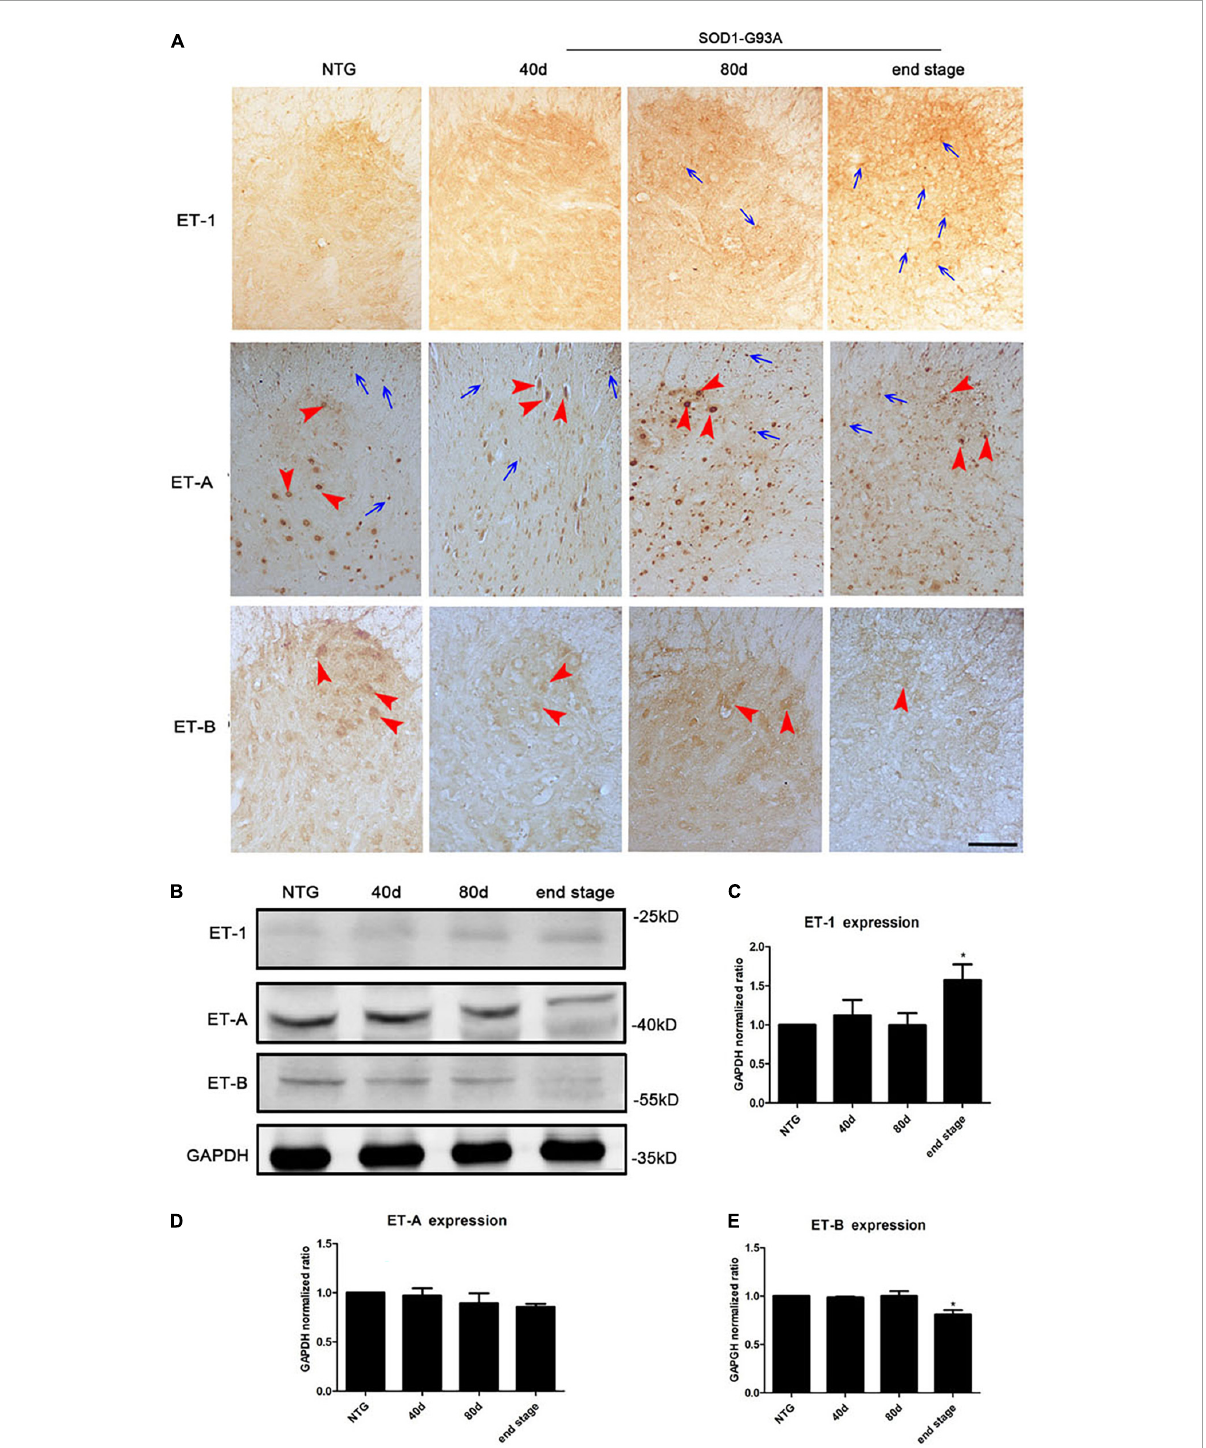
FIGURE1 Expression changes of ET-1, ET-A, and ET-B receptors at the end stage of SOD1-G93A mice. (A) Immunohistochemical detection of ET-1, ET-A, and ET-B receptors in the lumbar spinal cord of non-transgenic (NTG) mice and SOD1-G93A transgenic mice at 40 days (d), 80 days (d) and end stage. (B) Western blot analysis of ET-1, ET-A, and ET-B receptor levels in the lumbar spinal cord of NTG mice and SOD1-G93A transgenic mice at 40d, 80d and end stage. (C–E) Quantitative analysis of B. Statistical significance was assessed by one-way ANOVA followed by LSD- t test. Data represent the mean ± SEM. P (ET-1, end stage vs. NTG) = 0.037; P (ET-A, end stage vs. NTG) = 0.159; P (ET-B, end stage vs. NTG) = 0.004. n = 3. *P < 0.05. The arrows indicate glial cells, and the arrowheads indicate neurons. Bar = 100 µ